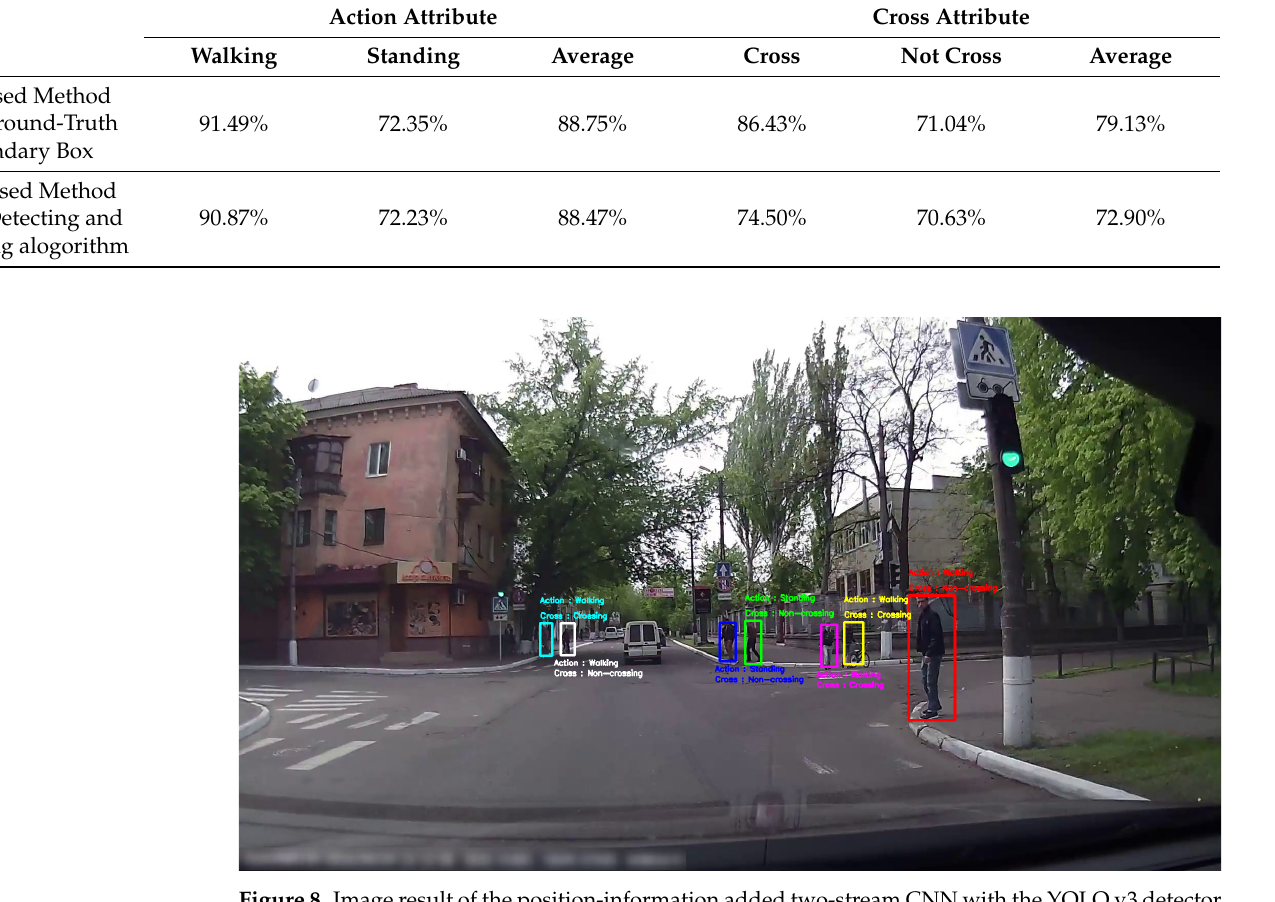
Figure 8. Image result of the position-information added two-stream CNN with the YOLO v3 detector and the Siamese fully convolutional